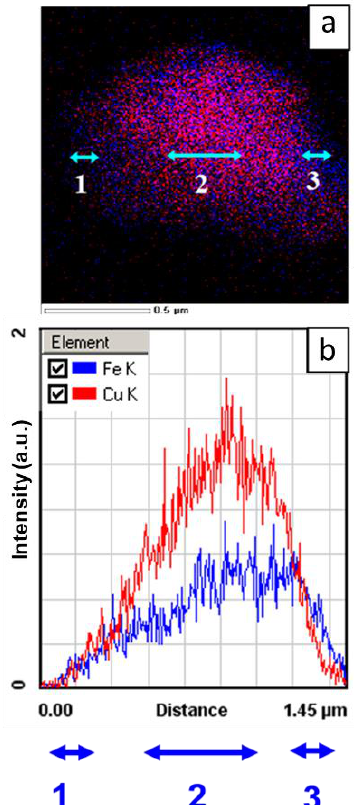
Figure 4. SEM images of the powder particles formed after 90 min of milling of the 67Cu – 33Fe